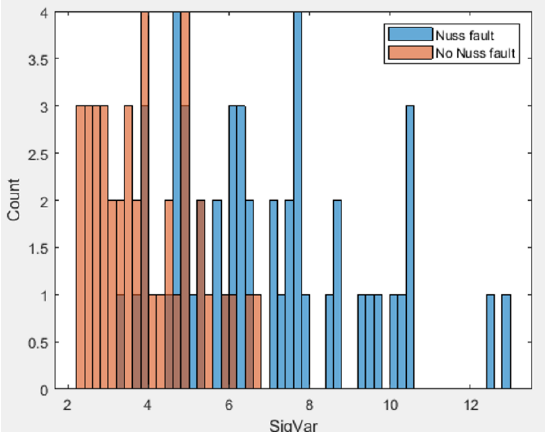
Fig. 10 . Histograms for the Nuss factor (the effect of icing on changes in the performance of Nuss sensors) according to Var.